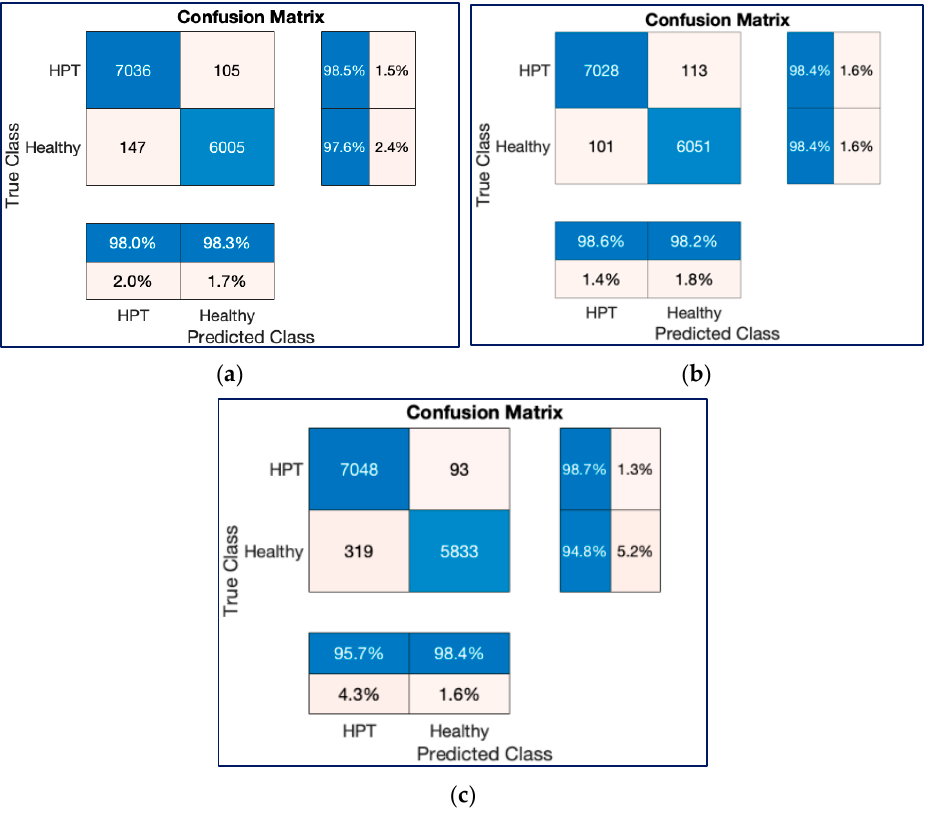
Figure 18. Confusion chart results for one of the classification processes with 132,968 spectrogram images in a trial on the 10 ‐ FCV. ( a ) ResNet18, ( b ) ResNet50, ( c ) ConvMixer.